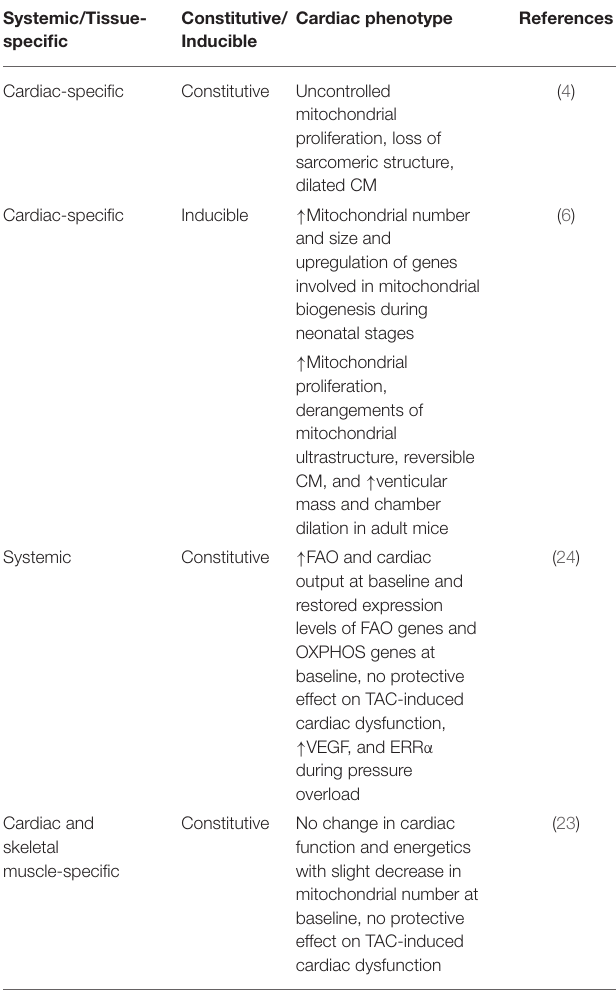
TABLE 1 | Cardiac and energetic phenotypes of PGC-1 α overexpression mouse models. Systemic/Tissue-